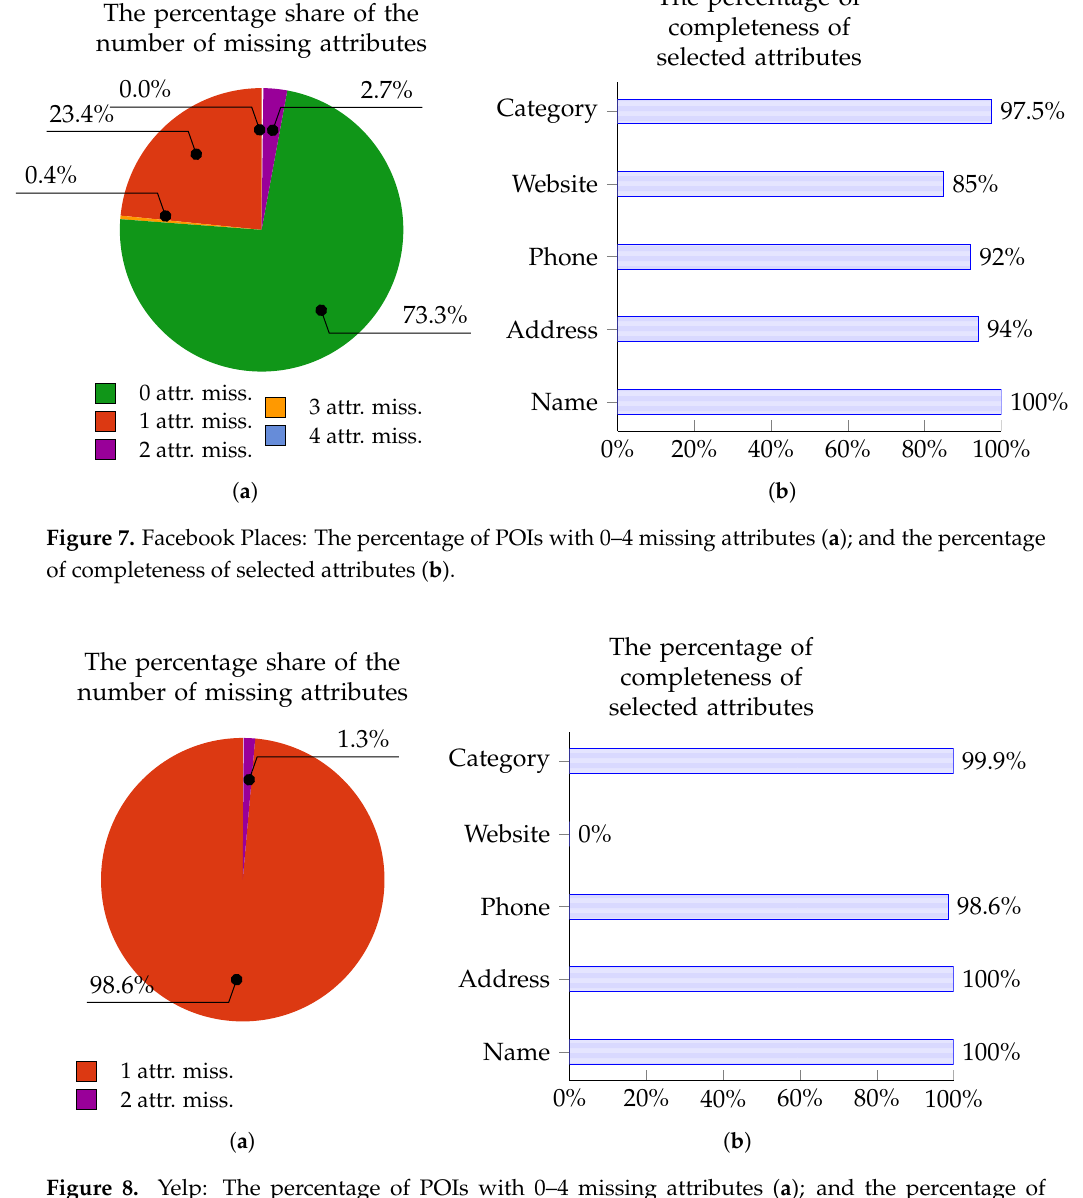
Figure 8. Yelp: The percentage of POIs with 0–4 missing attributes ( a ); and the percentage of completeness of selected attributes ( b